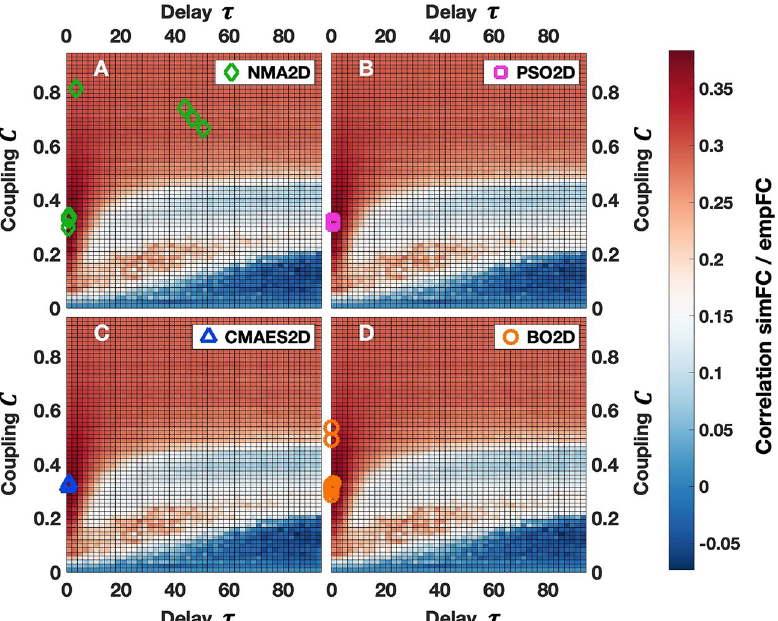
Figure 1. Examples of the algorithms’ solutions in the 2Dim parameter space. All plots illustrate the outcome for the same subject. As indicated in the legends, the results of the 2Dim parameter optimizations via NMA (NMA2D), PSO (PSO2D), CMAES (CMAES2D) and BO (BO2D) are visualized by colored symbols (diamonds, squares, triangles and circles, respectively). For each method, 15 optimal parameter points obtained from 15 algorithm executions with random initial conditions are indicated. The background fill of the plots illustrates the shape of the parameter space as discovered by the grid search, see also Fig. S1. It shows the similarity (Pearson correlation) between simulated and empirical FC on a color scale reaching from dark blue (low similarity) to dark red (high similarity). The figure was created with MATLAB R2018a (www. mathw orks. com).